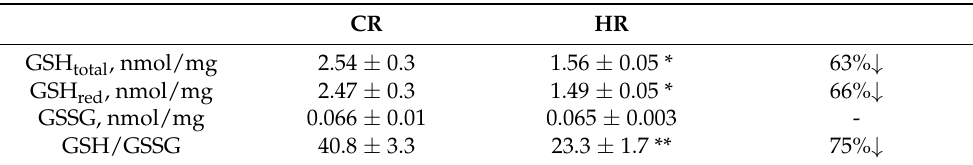
Table 5. The concentrations of GSH total , GSH red , GSSG and GSH/GSSG ratio in heart mitochondria from control and hyperthyroid